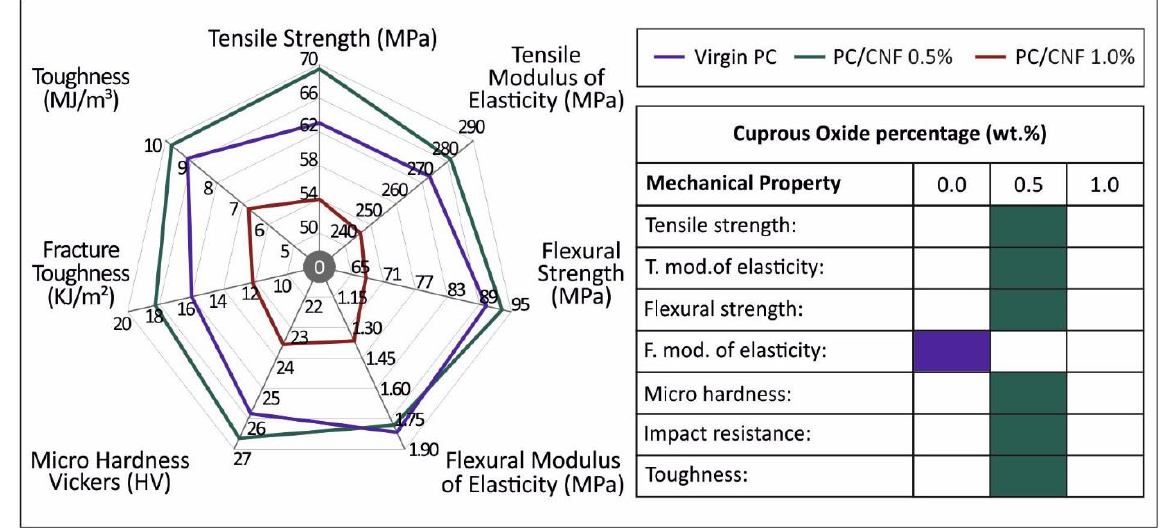
Figure 11. Summary of the results presented through the mechanical analysis of the study. The right side indicates the highest measured values of each measurement.